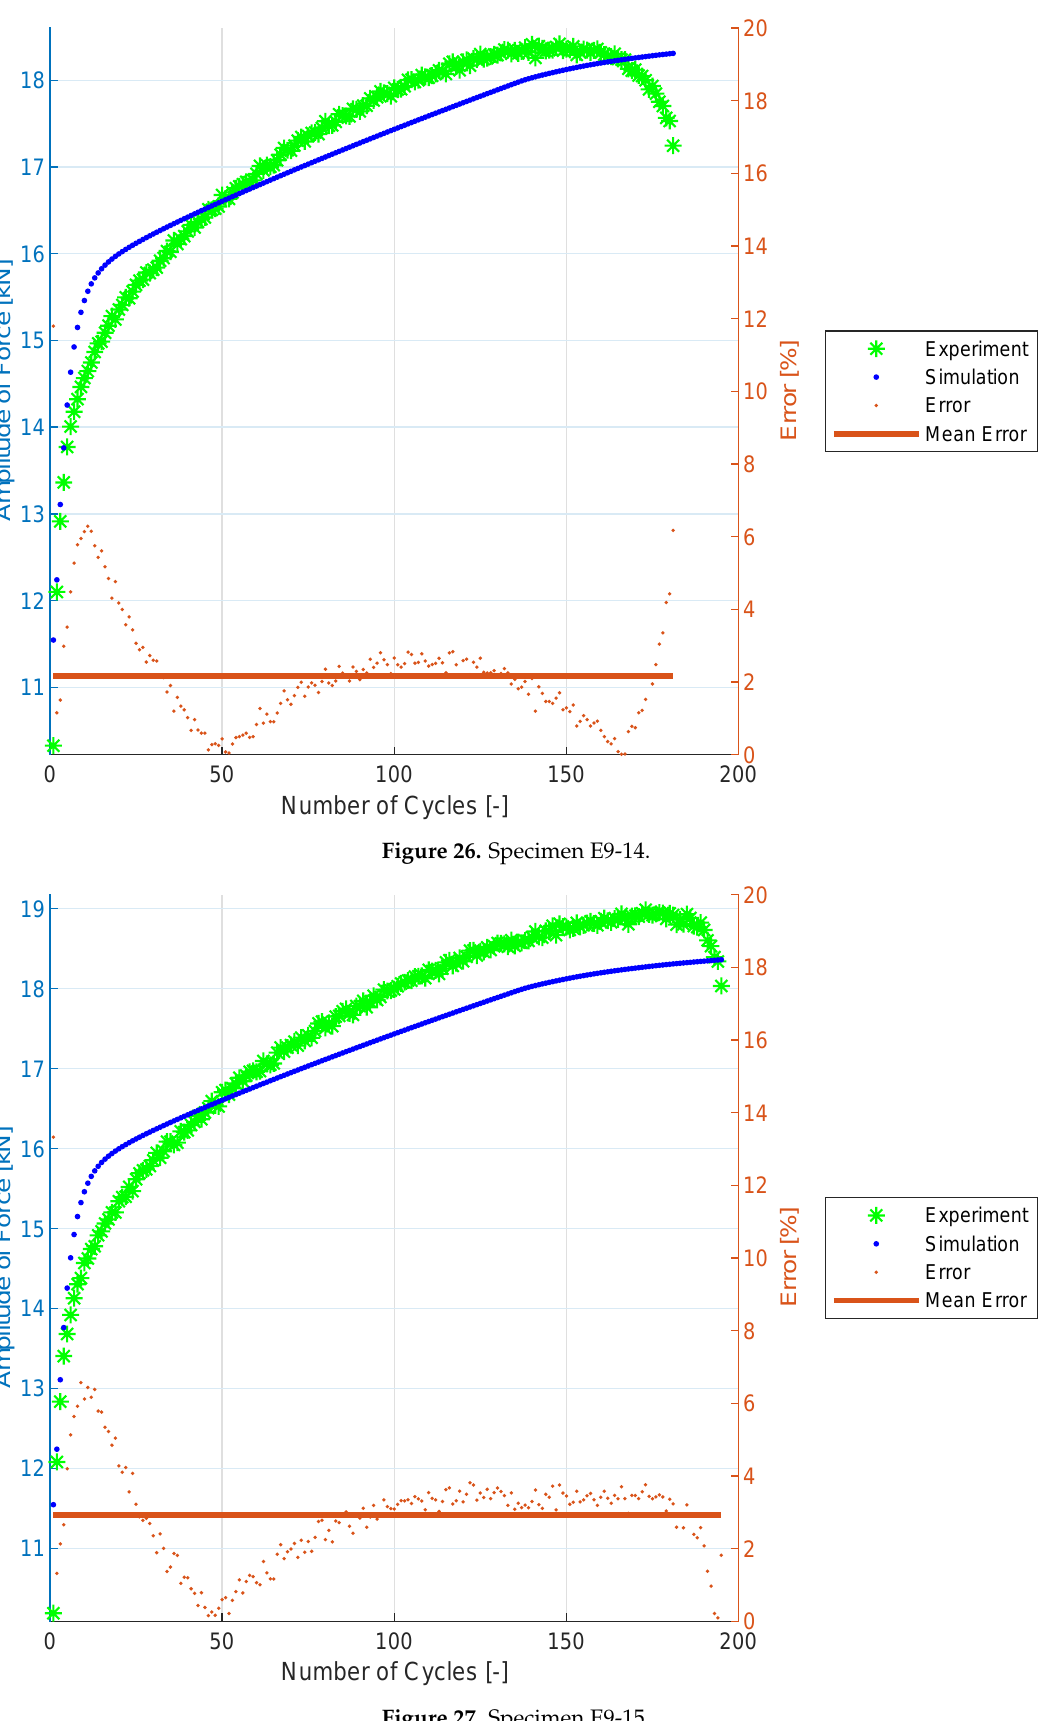
Figure 27. Specimen